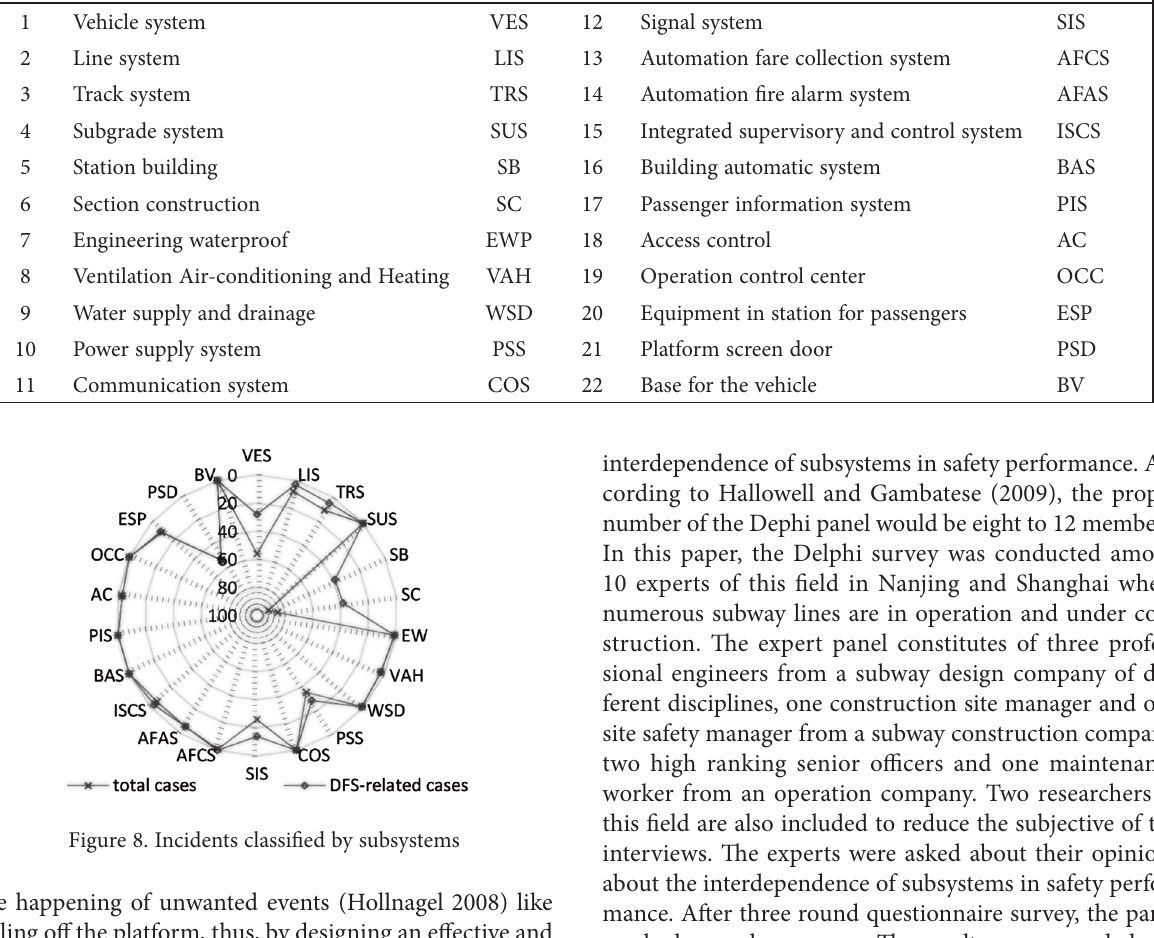
Table 3. modified subsystems and their abbreviations in China’s code for metro design Num. Name of the subsystems